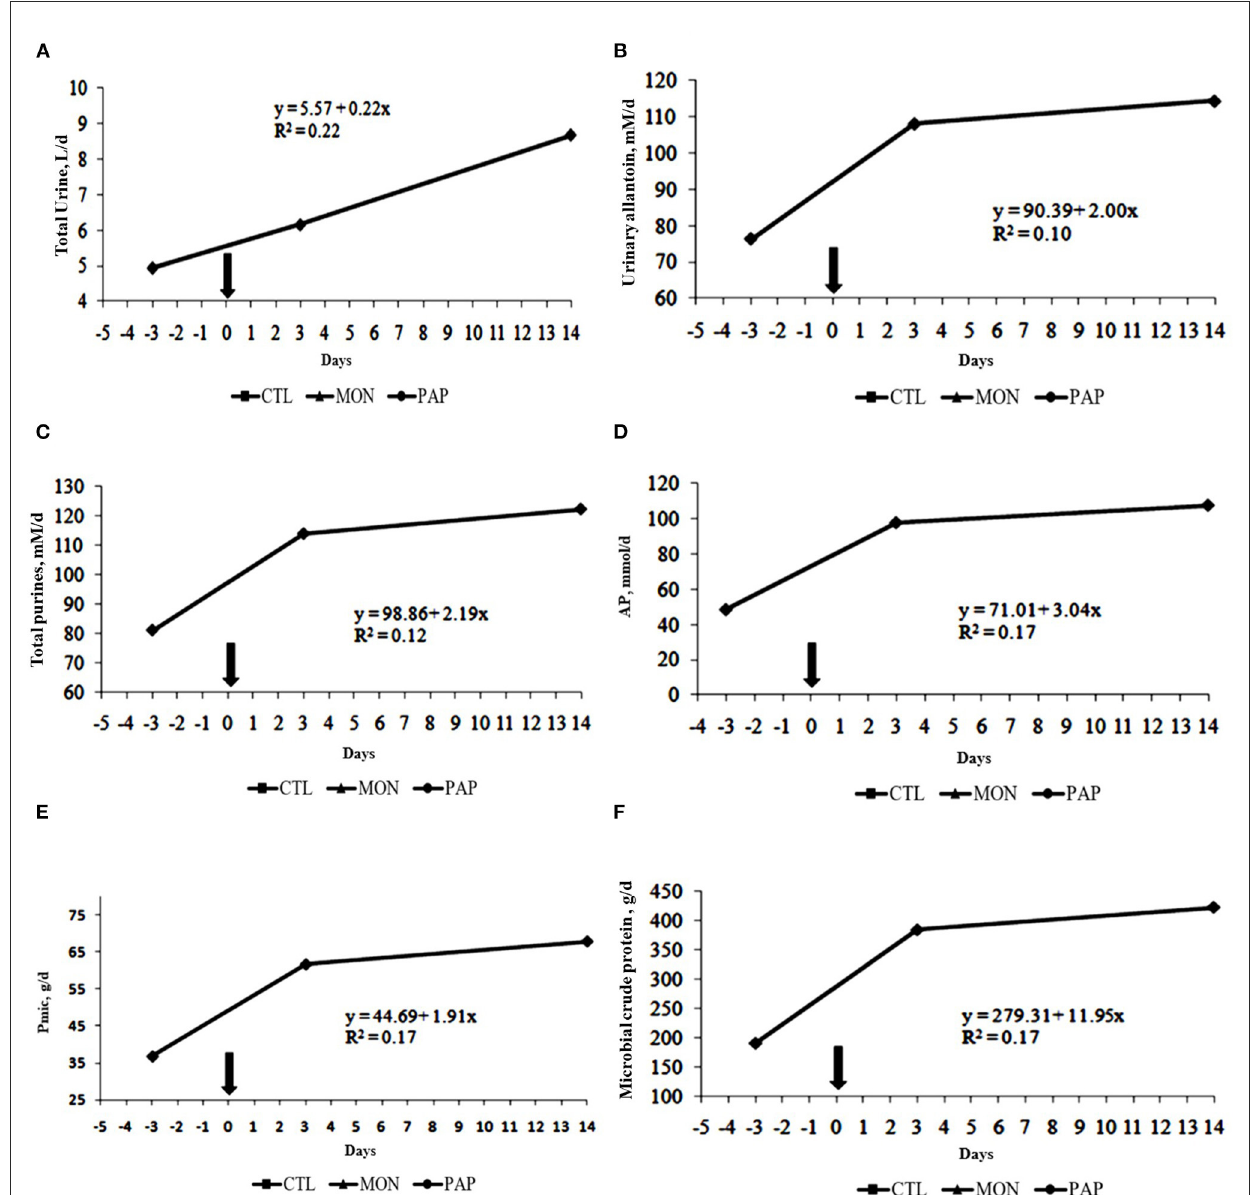
FIGURE3 Total urine excreted (A) , urinary allantoin (B) , total purines (C) , and absorbed microbial purines (D) , microbial-N (E) and microbial crude protein (F) of cows induced to ruminal acidosis. The bold arrow represents the change from the 100% forage diet to the 74% concentrate diet containing the